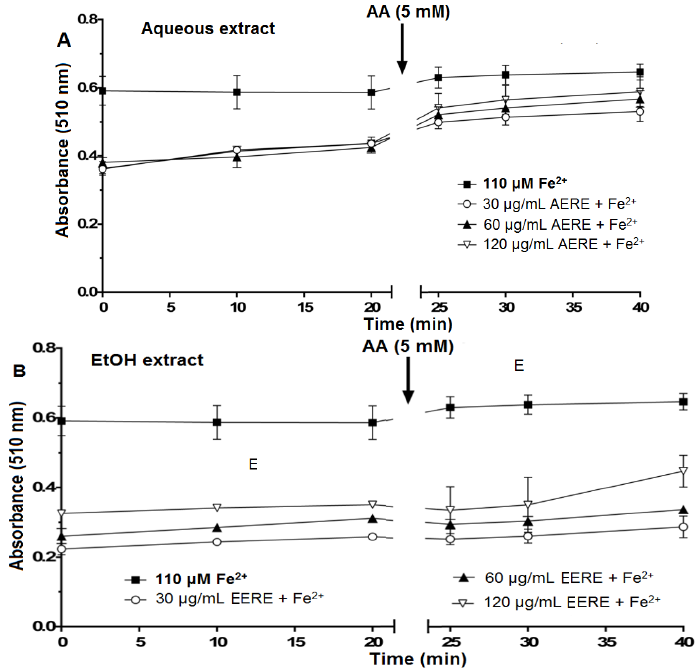
Figure 5. Oxidation of Fe 2+ by aqueous ( A ) and ethanolic ( B ) extracts from the leaves of R.